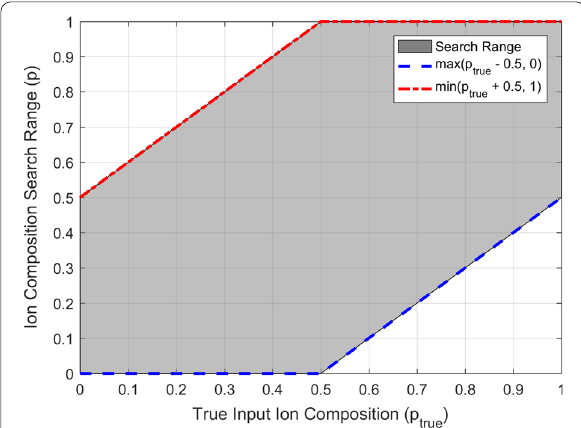
Fig. 2 Graphic representation of the limited search interval of the ion composition parameter used in the PSO analysis of Wu et al. (2015). Maximum and minimum values of the search range are shown as red and blue dash‑dotted lines. The allowed search range is represented in gray color. The parameter p true is the true input ion composition value of the